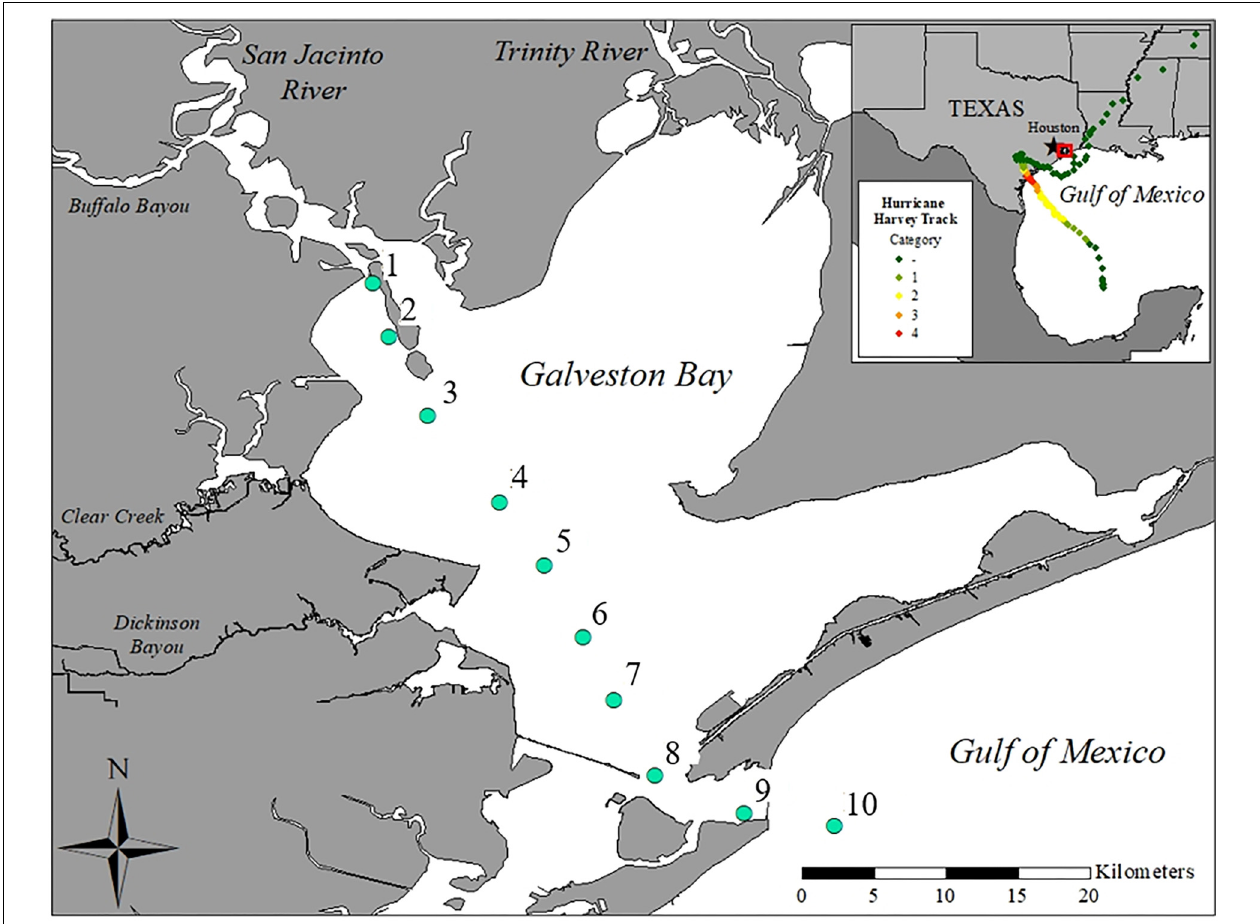
FIGURE 1 | Map of Galveston Bay, TX (United States) showing the ten stations sampled during each cruise labeled as stations 1–10. Inset shows location of Galveston Bay along the upper Texas coastline of the Gulf of Mexico. The color dotted line displays the path and landfalls of Hurricane